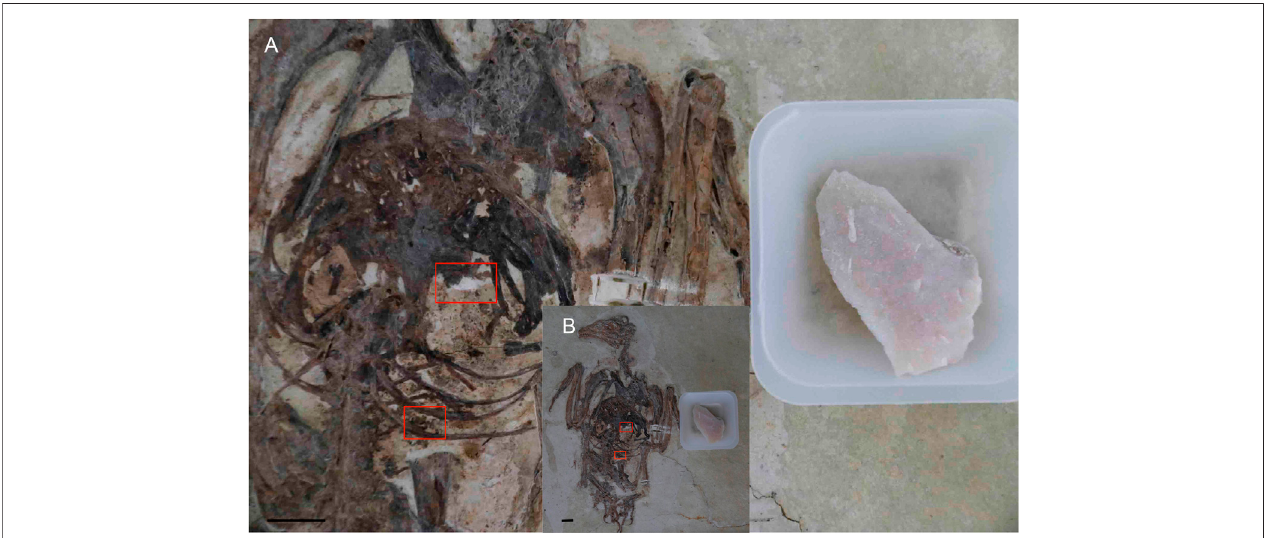
FIGURE 6 | Volume comparison between the purported gastroliths of Bohaiornis guoi IVPP V17963 and a 3.09 g piece of chert. Red rectangle indicates areas where the purported gastroliths occur. (A) close up photograph; (B) photograph of the entire specimen. Scale bar equals 1 cm.